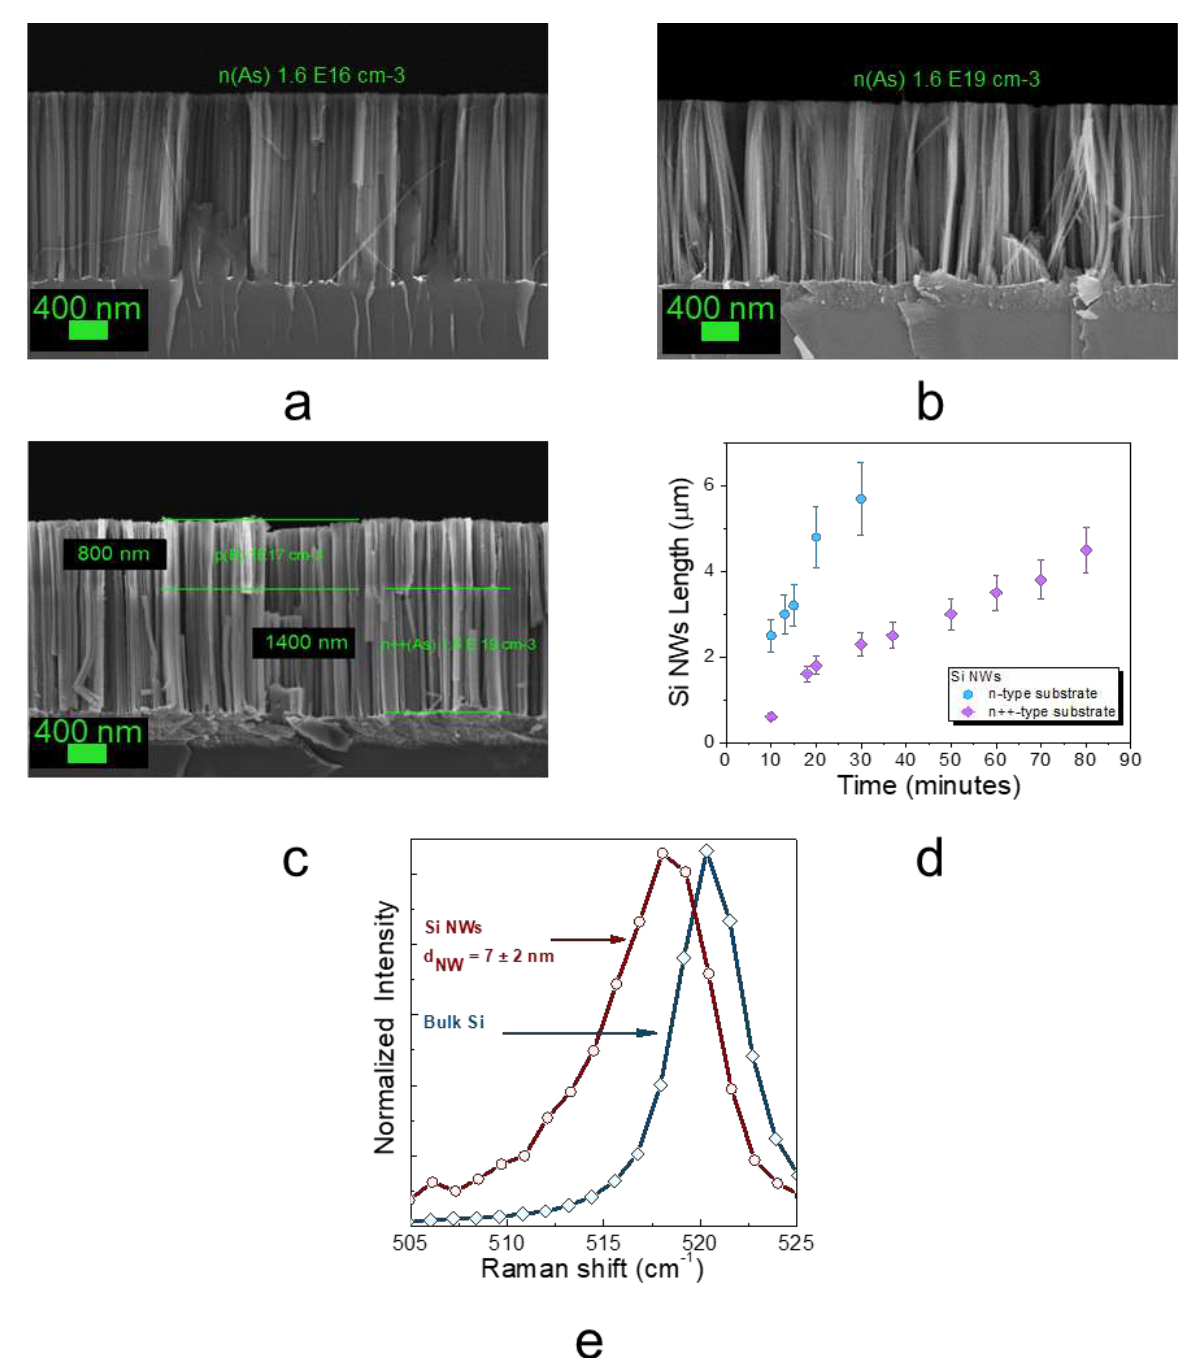
Figure 1. Cross-section SEM images of Si NWs realized starting from lightly n-doped (As atoms 1.6 × 10 16 cm − 3 , resistivity 5 Ohm × cm), heavily n-doped (As atoms 1.6 × 10 19 cm − 3 , resistivity 0.005 Ohm × cm), and p-n (B atoms 1 × 10 17 cm − 3 , resistivity 0.5 Ohm × cm and As atoms 1.6 × 10 19 cm − 3 , resistivity 0.005 Ohm × cm) substrates in ( a – c ) respectively. ( d ) Si NW length as a function of the etching time for lightly doped (indicated as n-type) and heavily doped n-type (indicated as n++-type) substrates ( e